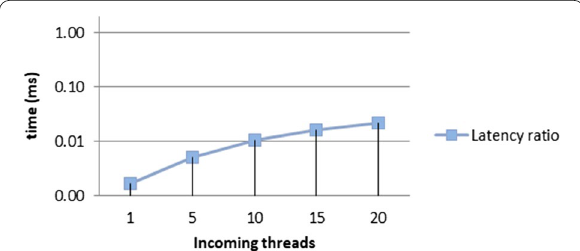
Fig. 8 Latency ratio of the proposed architecture for various